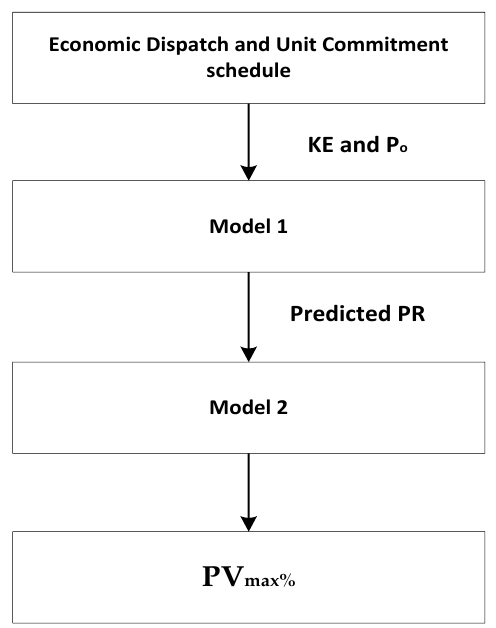
Figure 9. Combined approach of model 1 and model 2 to predict PV max% .